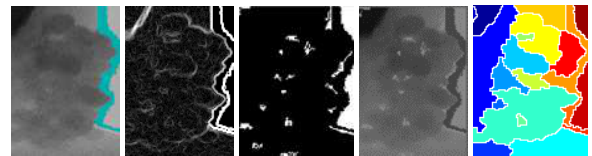
Figure 12: Watershed segmentation results based on the range image: Original range image, gradient magnitude, regional maxima, regional maxima superimposed on original range image and colored watershed label matrix (from left to